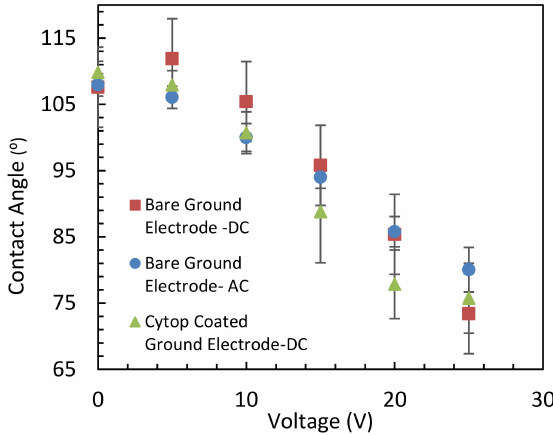
Figure 5. Comparison of sessile-drop electrowetting with a bare ground electrode and forward DC voltage, a bare ground electrode and forward AC voltage, and a Cytop-coated ground electrode and forward DC